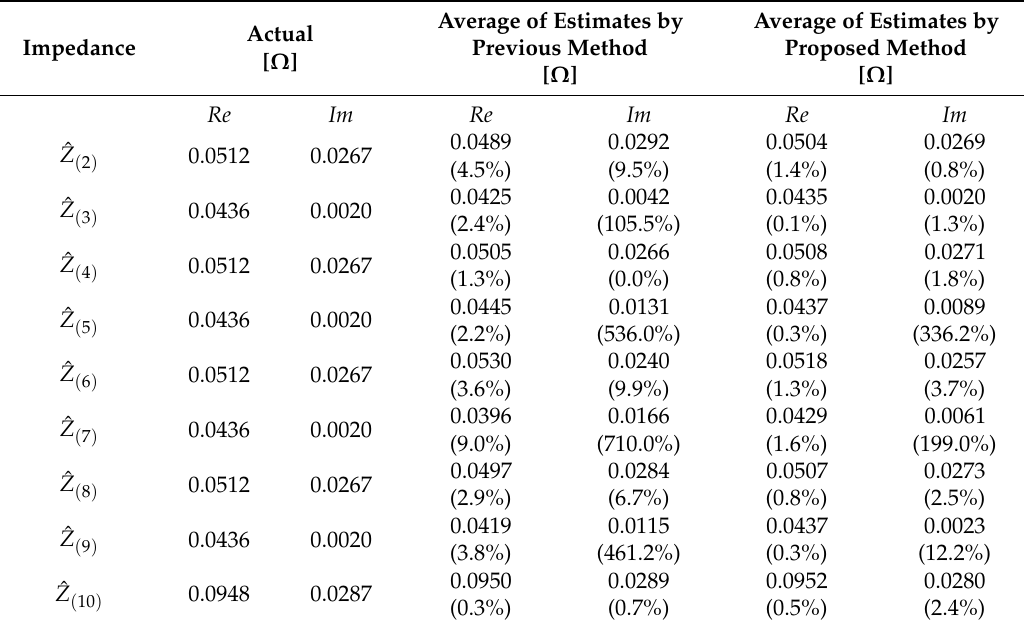
Figure 4. Average and 95% confidence interval for error of estimated impedance (real and imaginary part). Table 2. Simulation result of impedance